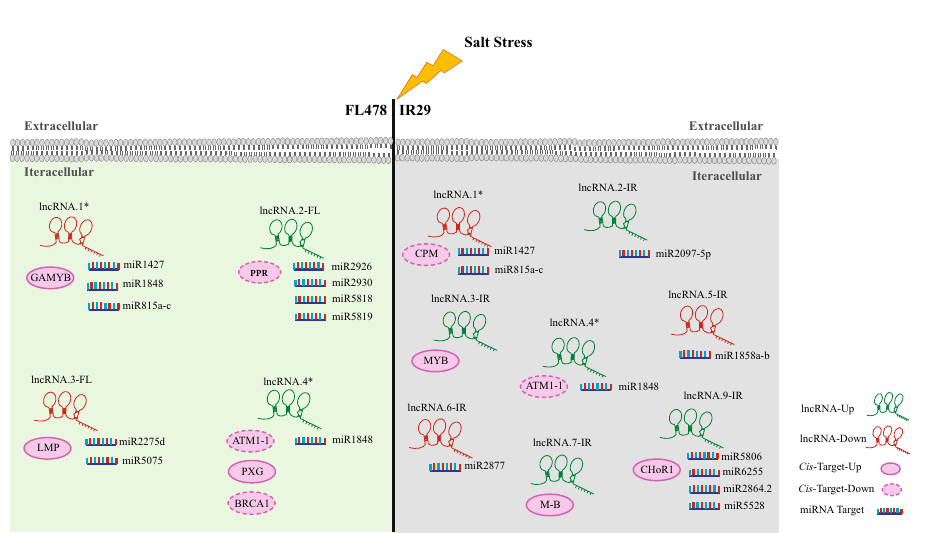
Figure 2. Schematic representation of lncRNAs and their targets including miRNA targets and cis -targets. ( LMP: lipid metabolic process, PPR: pentatricopeptide repeat protein, CMP: component of plasma membrane, M-B: